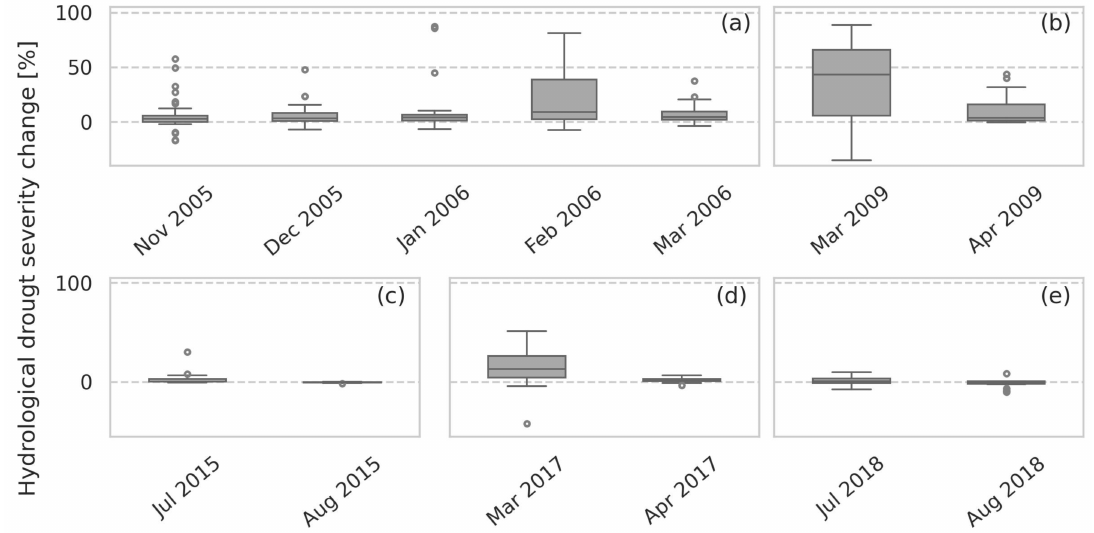
Figure 10. Hydrological drought severity changes in subbasins where forest conservation is applied and in subbasins downstream of where it is applied: event I ( a ), event II ( b ), event III ( c ), event IV ( d ), event V ( e